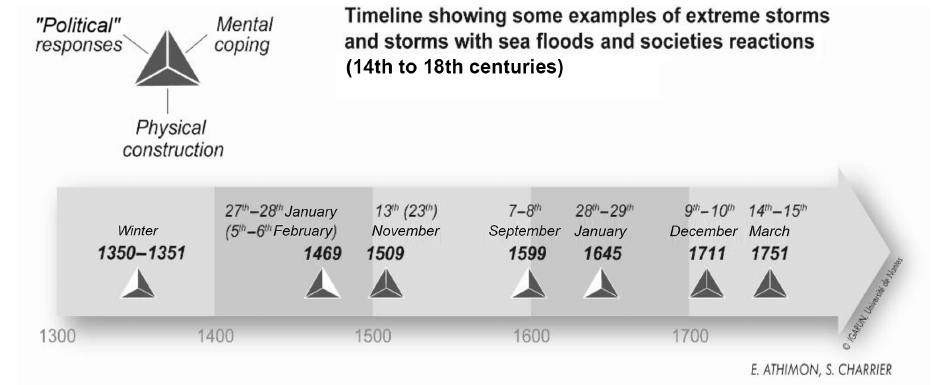
Figure 4. Major storms and the societies’